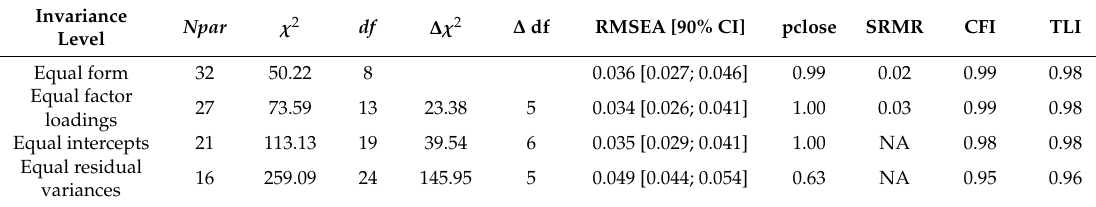
Table A4. Comparison of nested models for the CRS-5 between 2012 and 2018.